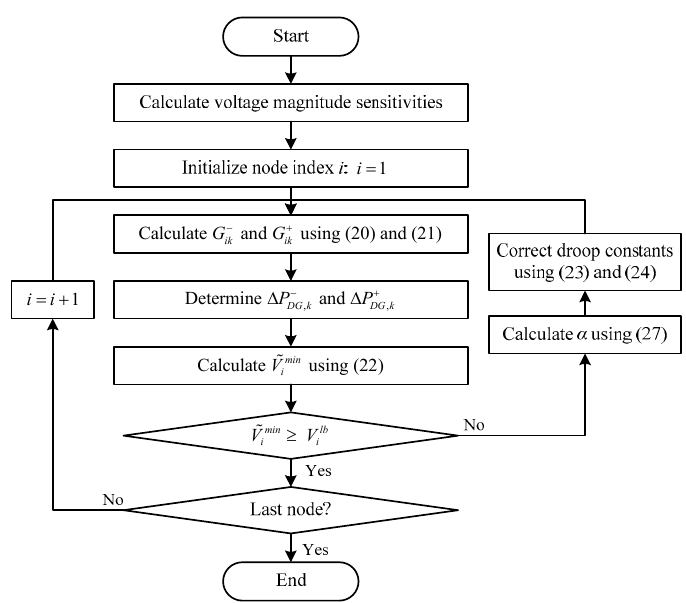
Figure 7. Flow chart of the final correction.